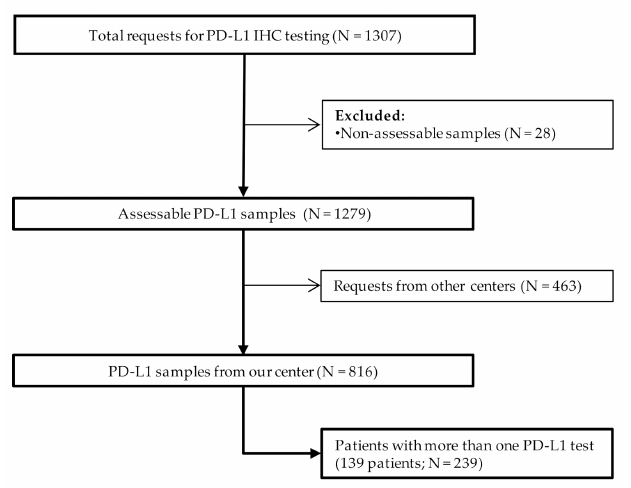
Figure 1. Flow chart of the patients included in the study cohort. Abbreviations: PD-L1, programmed cell death ligand 1; IHC, immunohistochemistry; NSCLC, non-small cell lung